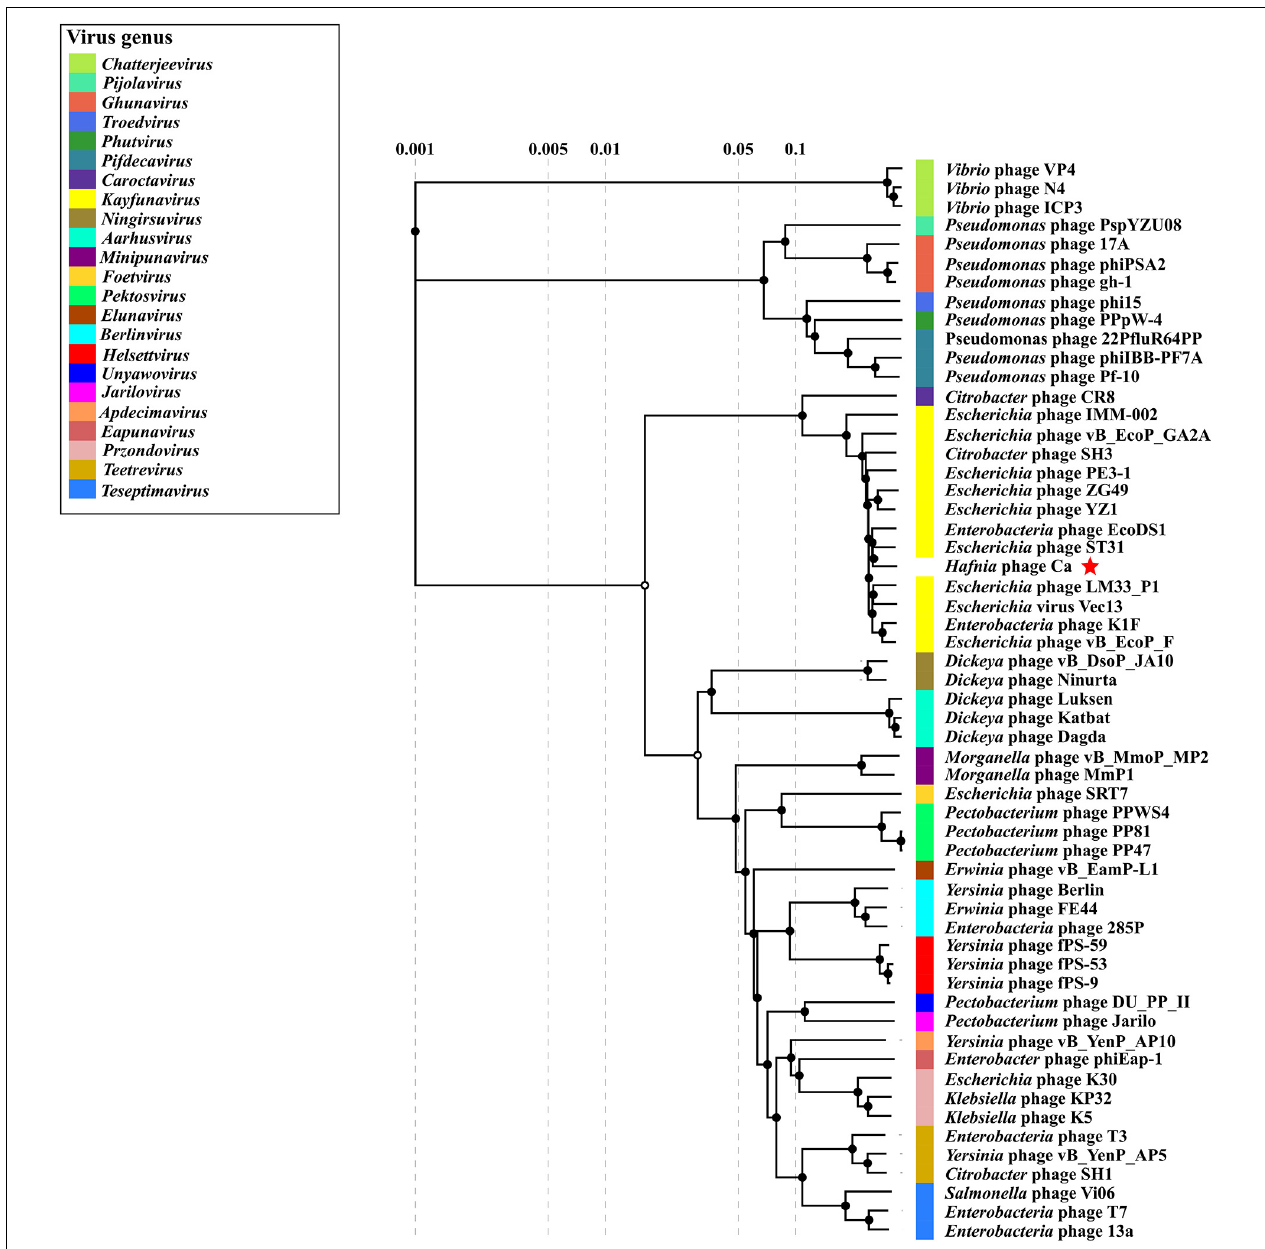
FIGURE 6 | Proteomic tree of Hafnia phage Ca and 56 classified phages of the 23 genus of subfamily Studiervirinae of family Autographiviridae. The proteomic tree is generated using ViPTree online based on genome-wide similarities determined by tBLASTx. Bacteriophage family assignments according to the official ICTV classification (2021) are provided with different color bars. The red star indicates phage